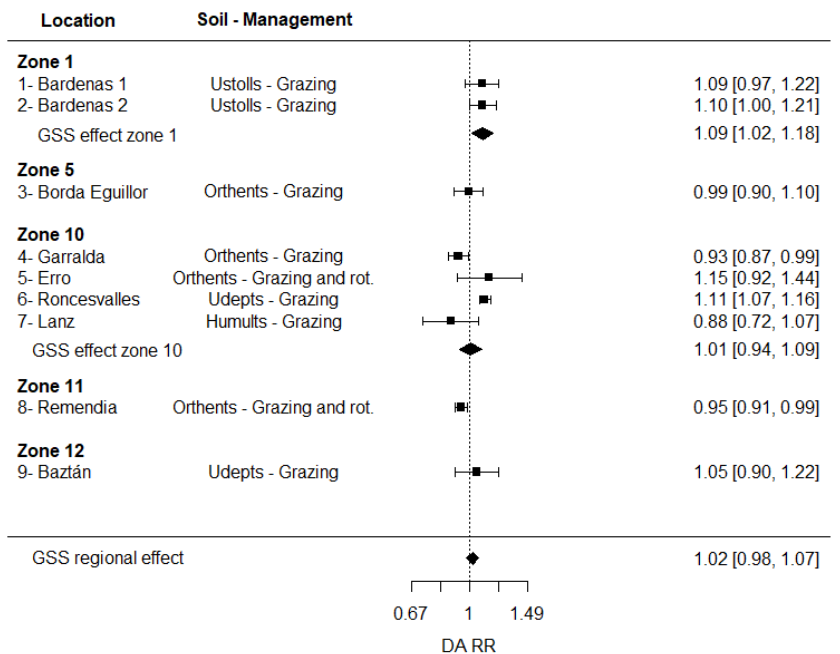
Figure 10. Response ratio (RR) of BD (0–30 cm) for the adaptive management strategy of controlled grazing and/or rotation in grasslands (GSS). Zones correspond to those in Figure 1. The effect was considered significant when the 95% confidence interval (CI) of the RR did not overlap one ( α = 0.05). Soil and management column includes information about principal soil group and management considered in each group.